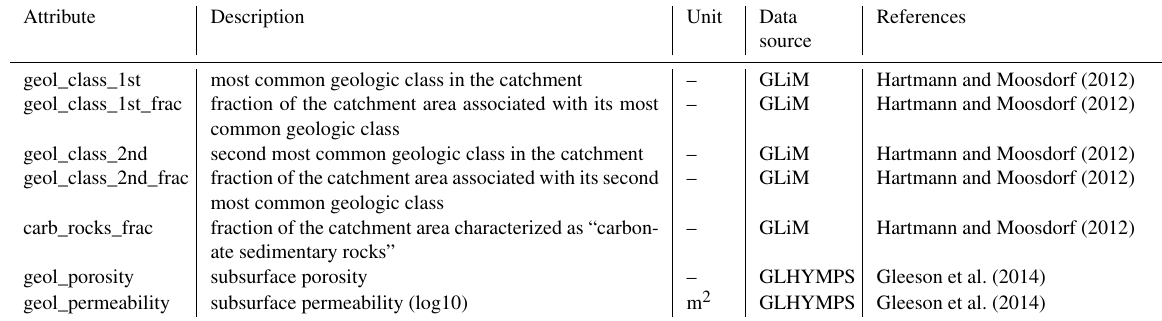
Table 6. Geological